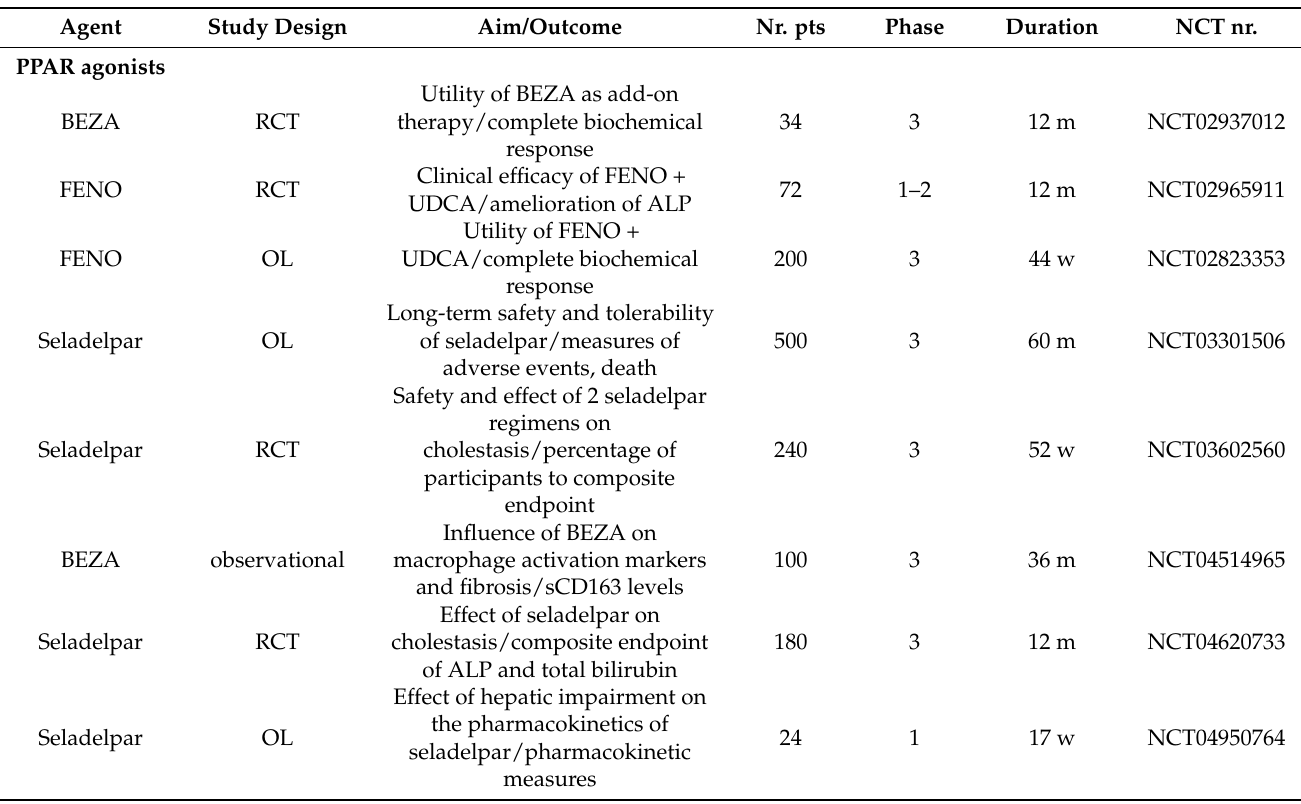
Table 1. Ongoing controlled trials with experimental agents in